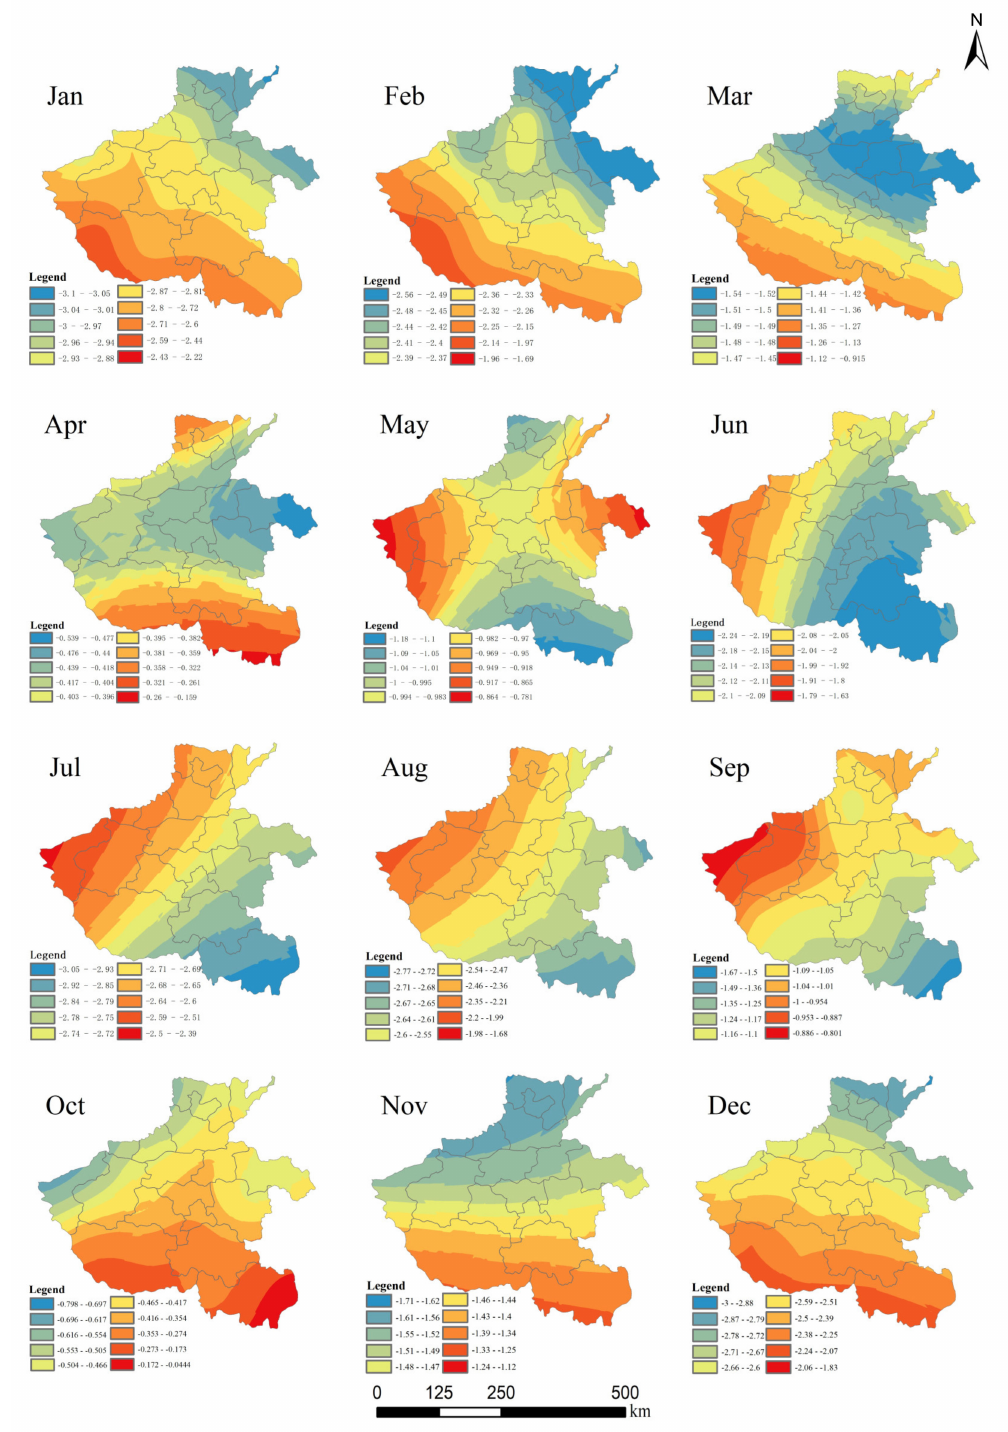
Figure 5. The monthly spatial variation of the TCCI in Henan Province is based on the observation data of meteorological stations from 1960 to 2020. (Note: TCCI of each month is divided into ten grades, and the value range of each month is different. Therefore, comparisons between months cannot be made according to the colors in the